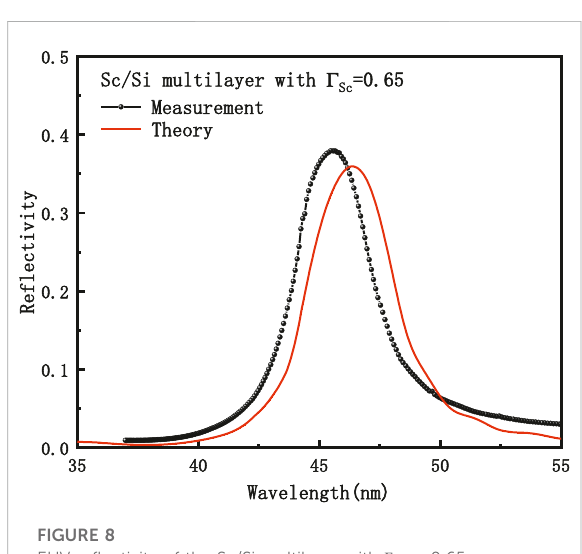
EUV re fl ectivity of the Sc/Si multilayer with Γ Sc =